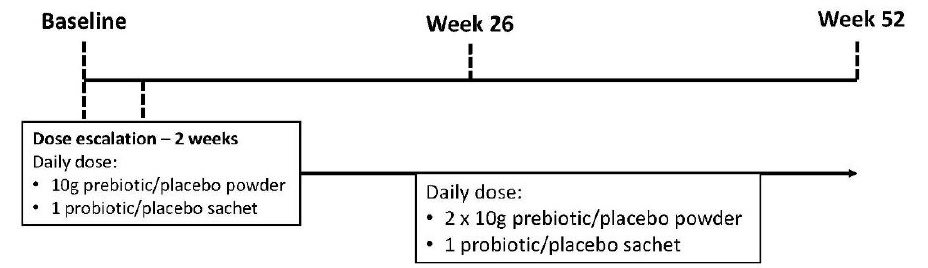
Figure 1. The Synbiotics Easing Renal Failure by Improving Gut Microbiology II (SYNERGY II) study schema.